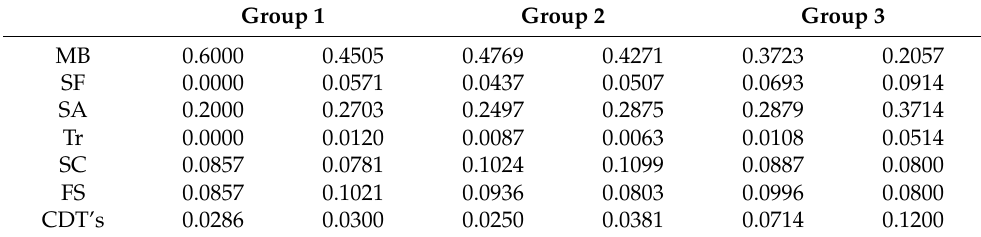
Table 4. Saving values ratios.